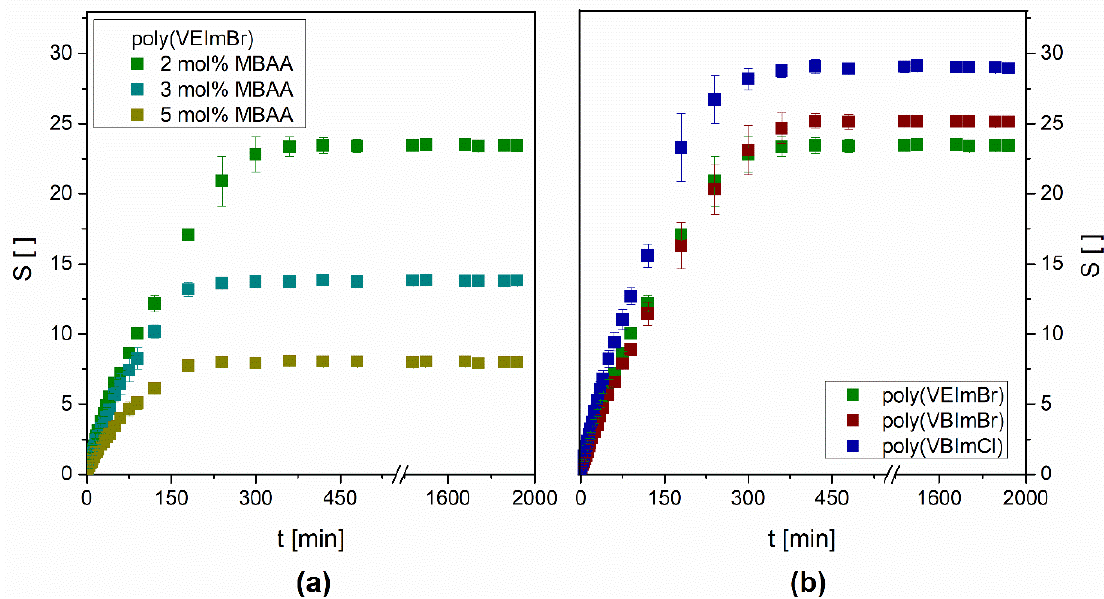
Figure 2. Water swelling kinetics ( a ) of poly(VEImBr) with different MBAA amounts (30 ± 1 °C; n = 3) and ( b ) of different monomers (30 ± 1 °C; n = 3; MBAA: 2 mol%).